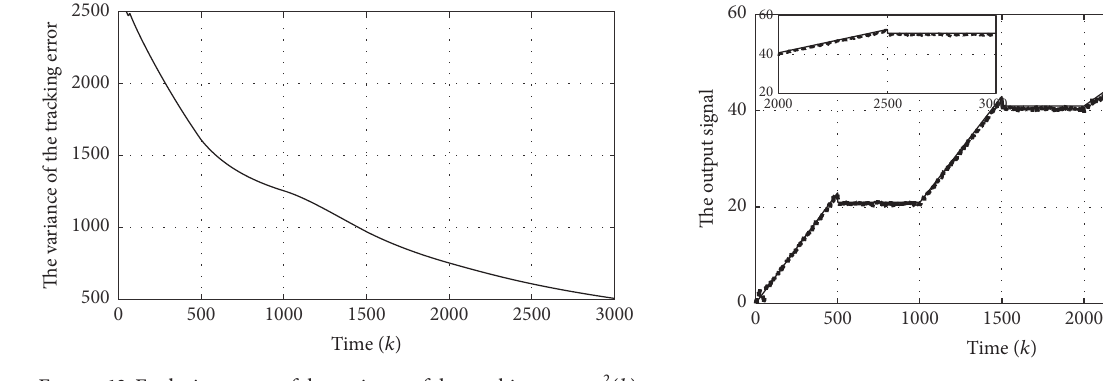
Figure12:Evolutioncurveofthevarianceofthetrackingerror 𝜎 2 𝜐 (𝑘) (control scheme (1) ).